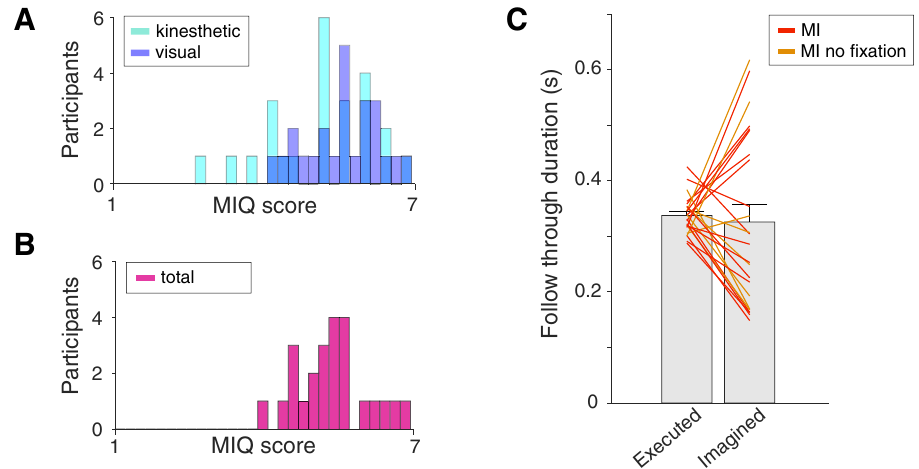
Figure 5. Measures of motor imagery. ( A , B ) Histograms of the MIQ scores of all motor imagery participants, divided into ( A ) measures of visual and kinesthetic imagery ( B ) and the total scores per participant. In each plot the range of possible scores (1–7) is binned into 30 units for visualisation. ( C ) Durations of executed and imagined follow-throughs for all participants in the motor imagery groups. The coloured lines indicate individual participants; bars show mean ± s.e. across